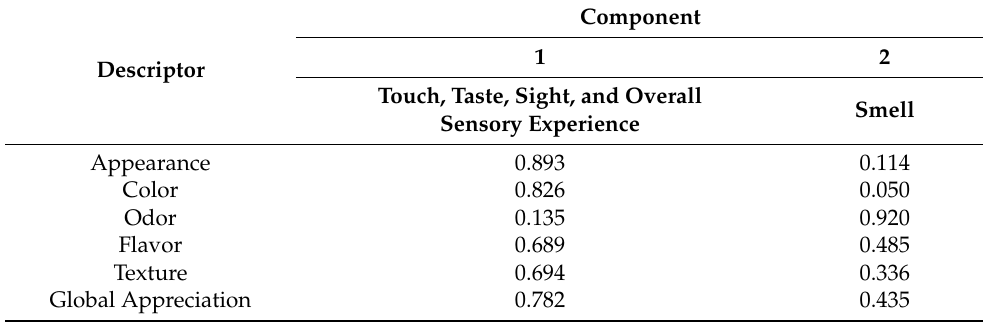
Table 9. Rotated component matrix for each smoked blue jack mackerel p â t é